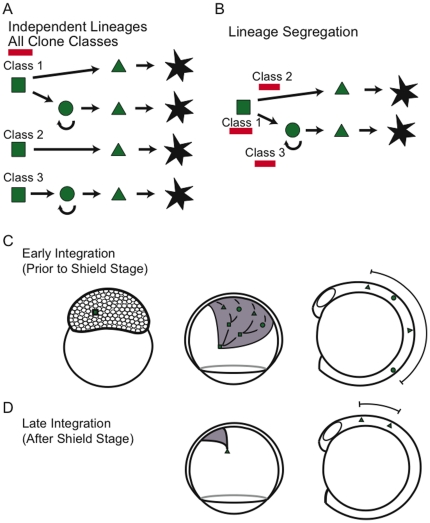
Alternative lineage models to explain clone classes.(A) Clone classes indicate independent lineages during the period of transposon integration or (B) clone classes represent different times of integration, either before (Class 1) or after (Class 2 and 3) segregation of fates from a common precursor. Red bars indicate time of integration in indicated clone class. Squares represent neural crest precursors, circles represent melanocyte stem cells, triangles represent melanoblasts or transient amplifying cells, and stars represent differentiated melanocytes. (C,D) Predictions for the effect of different times of transposon integration into a melanocyte precursor on clone size and clone dispersion over the A–P axis, using the model depicted in (B).